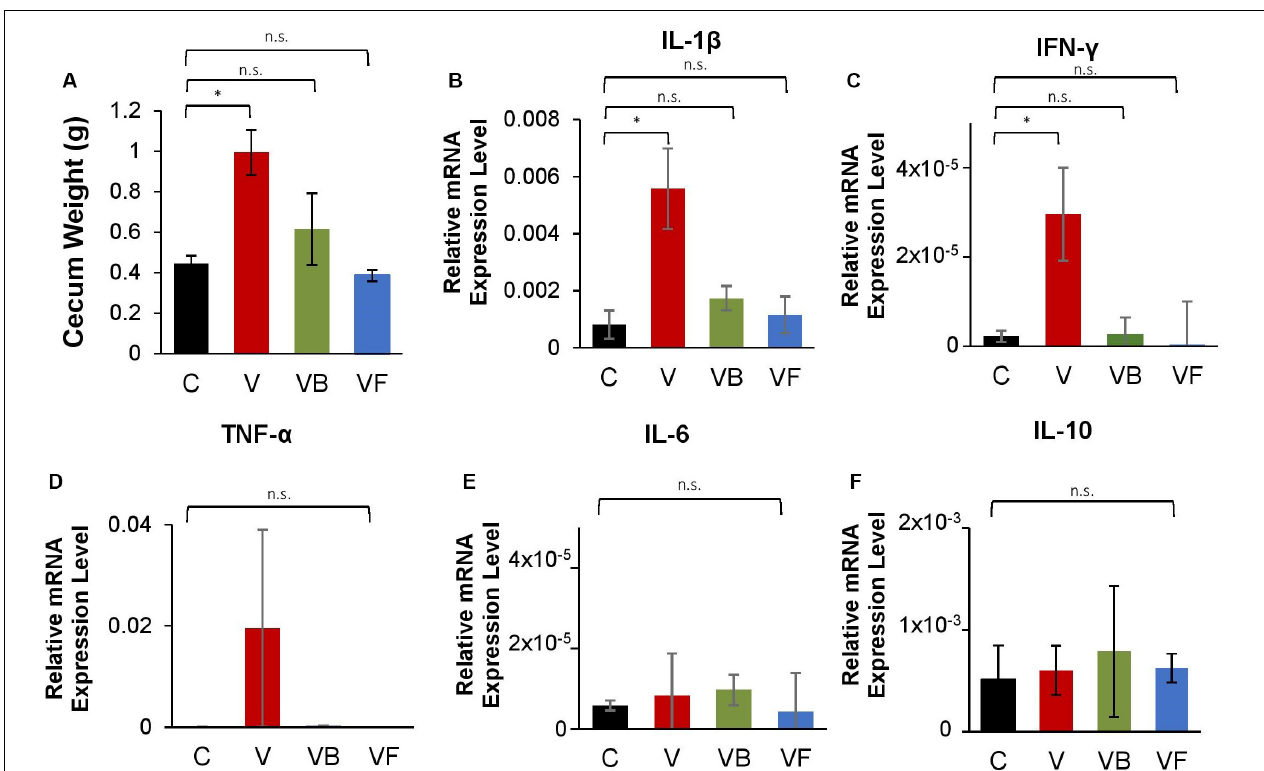
FIGURE 4 | Changes in cecum size and expression of inflammation-related genes in vancomycin-treated mice. At the end of the experiment, we measured cecum weight and measured the mRNA expression levels of inflammation-related genes in the large intestine for vancomycin-treated mice (C: control, V: vancomycin + natural recovery, VB: vancomycin + B . bifidum , VF: vancomycin + fecal transplant from control mice). (A) Cecum weight, relative mRNA expression of genes encoding (B) IL- β , (C) TNF- α , (D) INF- γ , (E) IL-6, and (F) IL-10 for vancomycin-treated mice, using Actb as a reference gene. Error bars indicate standard error, and significance was determined by One-Way ANOVA and Dunnett’s test. (* p < 0.05, ** p < 0.01, *** p <